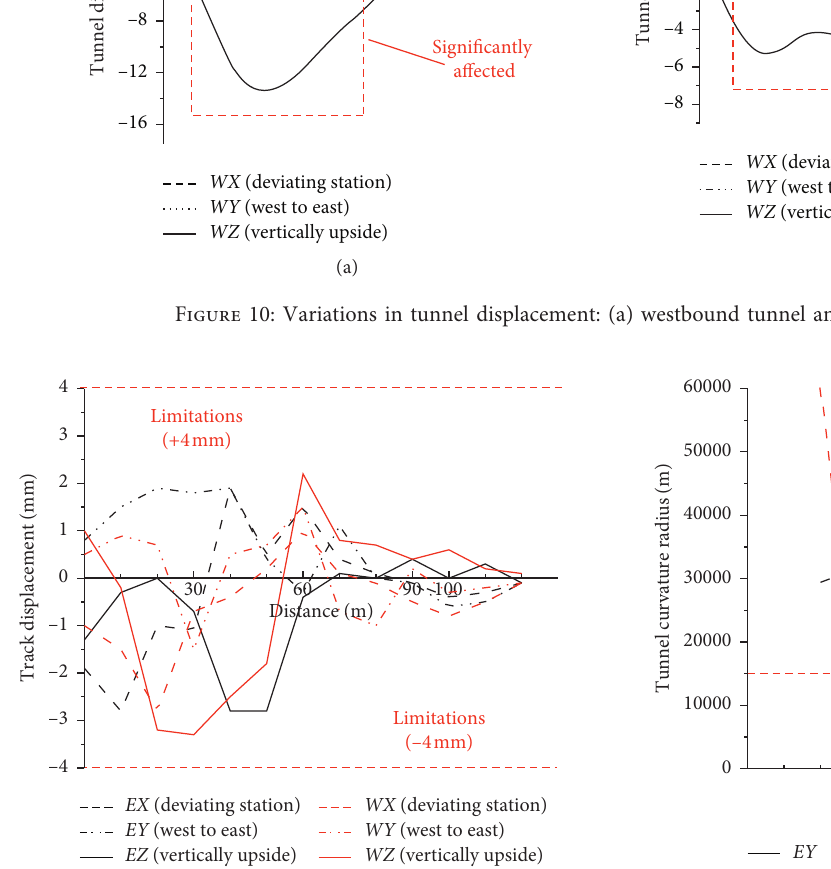
Figure 11: Variations in track bed displacement.